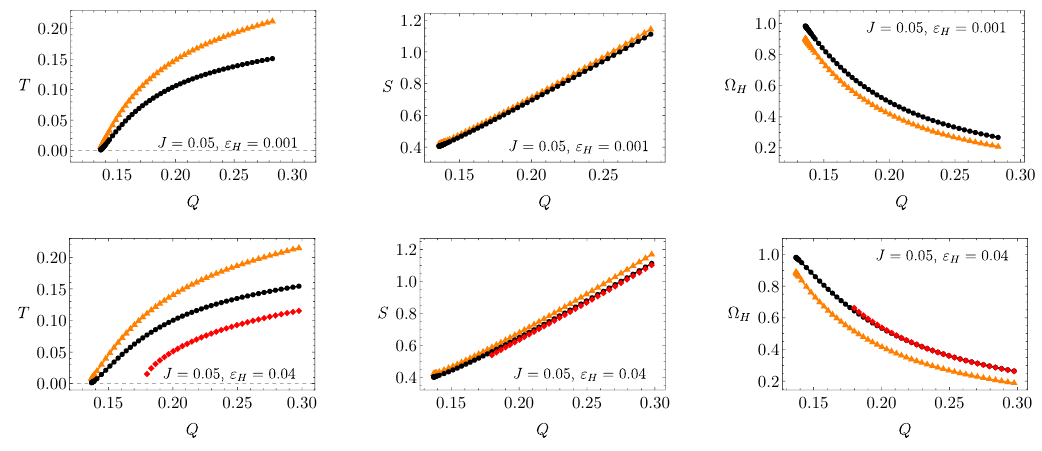
Figure 21 . First line : the comparison with the approximation of [13] for the same charge, mass, and angular momentum J = 0 : 05. Black disks are numerical results, and orange triangles are the predicted curves. For small charge, Q s =Q ’ 0 : 5%. Here the lowest T = 0 : 00127, and S = 0 : 405. The error in S close to the BPS bound is 2{4%. Note that in particular as T ! 0, (cid:10) H ! 1. Second line : red rhombi show the coexisting CLP black holes. For small charge, Q s =Q ’ 0 : 6%. Here lowest T = 0 : 00164, and S = 0 : 401. The error in S close to the BPS bound is